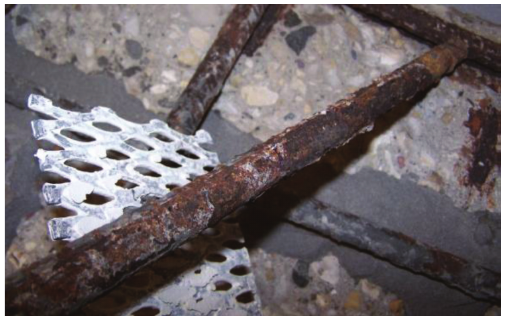
Figure 13: Steel rating of 4 (close-up of exposed Rebar of TSZ w/EP- C after 6